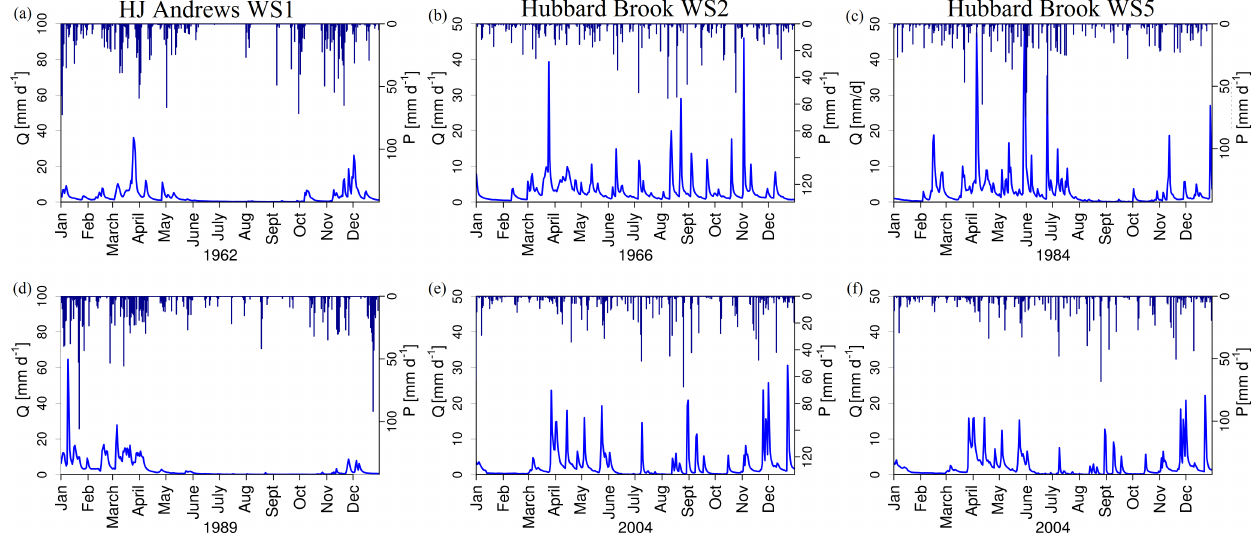
Figure 3. Hydrographs for HJ Andrews WS1 in (a) 1962 (annual precipitation P A = 2018, E p, A = 951mmyr − 1 ) and (b) 1989 ( P A = 1752, E p, A = 846mmyr − 1 ), Hubbard Brook WS2 in (c) 1966 ( P A = 1222, E p, A = 788mmyr − 1 and (d) 2004 ( P A = 1296, an- nual E p, A = 761mmyr − 1 and Hubbard Brook WS5 in (e) 1984 ( P A = 1480, annual E p, A = 721mmyr − 1 ) and (f) 2004 ( P A = 1311, E p, A = 731mmyr − 1 )